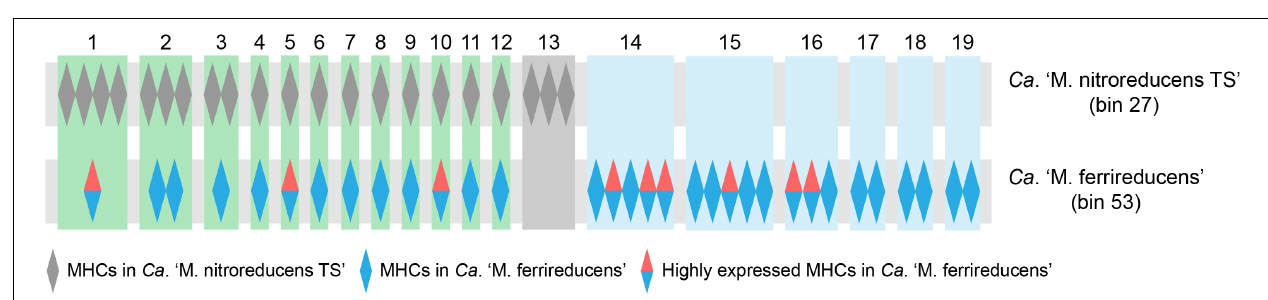
FIGURE 6 | Orthogroups of multiheme c -type cytochromes (MHCs) from Ca. “ M. nitroreducens TS” (bin_27) and Ca. “ M. ferrireducens ” (bin_53) based on orthology analysis. Each rectangle (green, gray, or light blue) is labeled by a number shown at the top and represents an orthogroup of homologous MHCs. The detailed information of the MHCs can be found in Supplementary Table 2